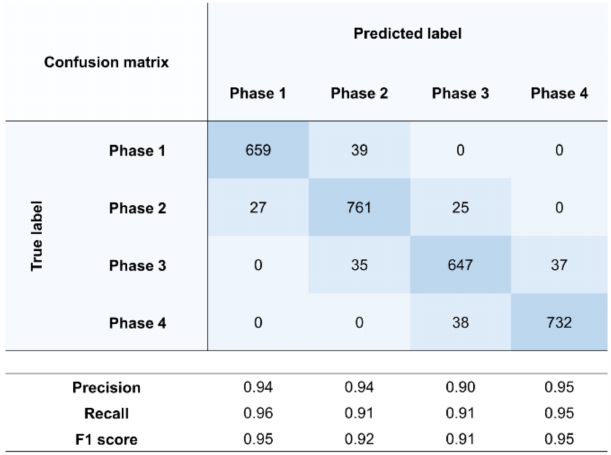
Figure 10. Confusion matrix, precision, recall, and f1 score of results of gait phase